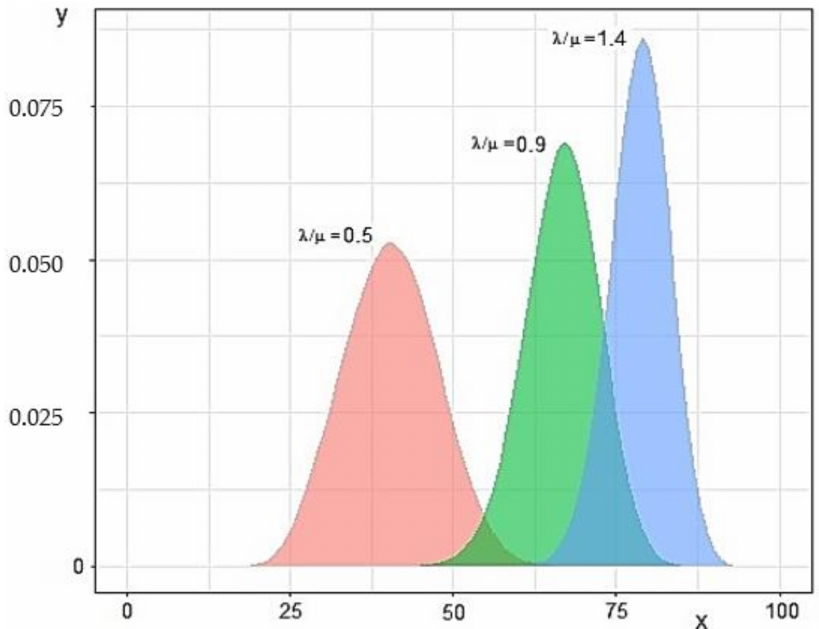
Figure 3. Probability distribution of individual states in the steady state, for λ / µ = 0.5, λ / µ = 0.9, λ / µ = 1.4. ( ρ = λ µ